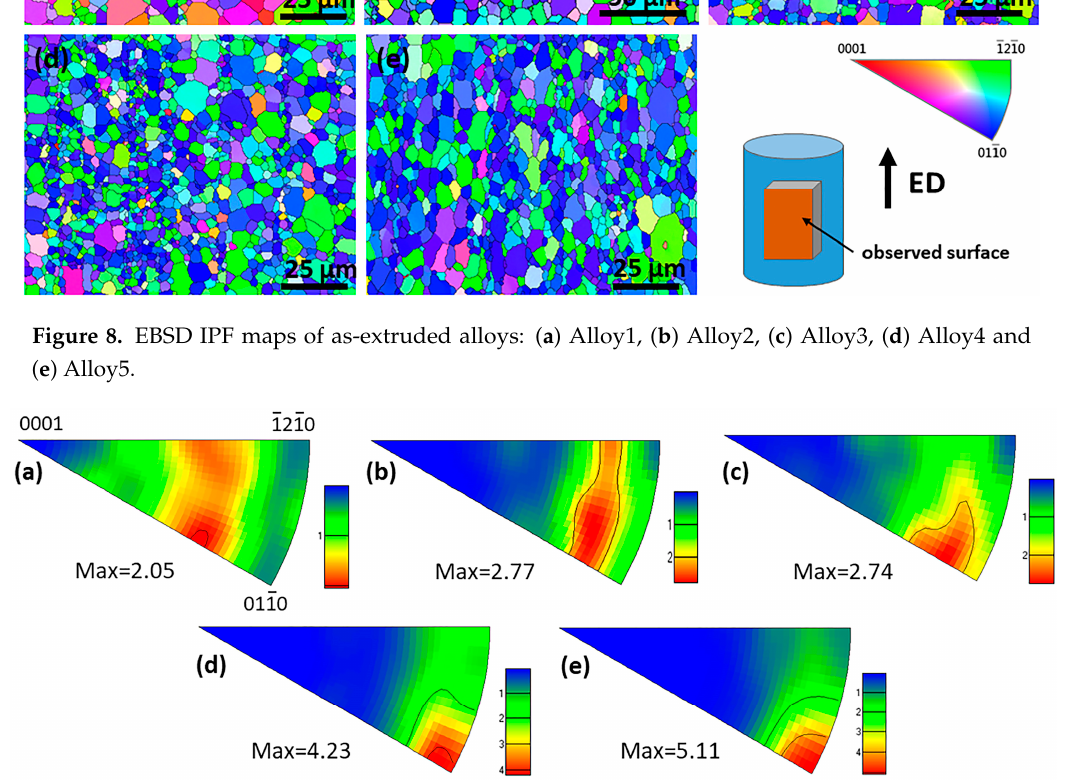
Figure 9. Inverse pole figures of as-extruded alloys refer to ED: ( a ) Alloy1, ( b ) Alloy2, ( c ) Alloy3, ( d ) Alloy4 and ( e ) Alloy5.